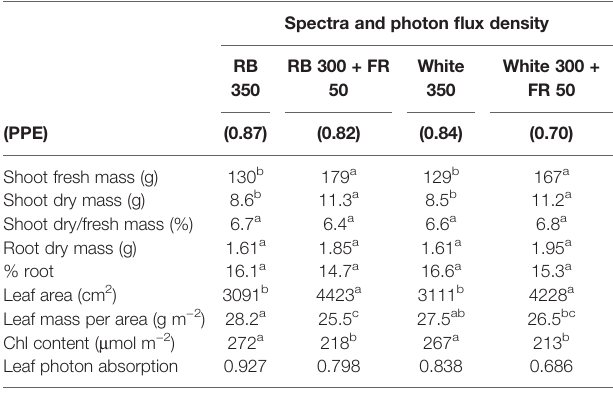
TABLE 1 | Effect of Spectral Quality on Growth, Morphology, and Chlorophyll Content of Lettuce. Spectra and photon fl ux density